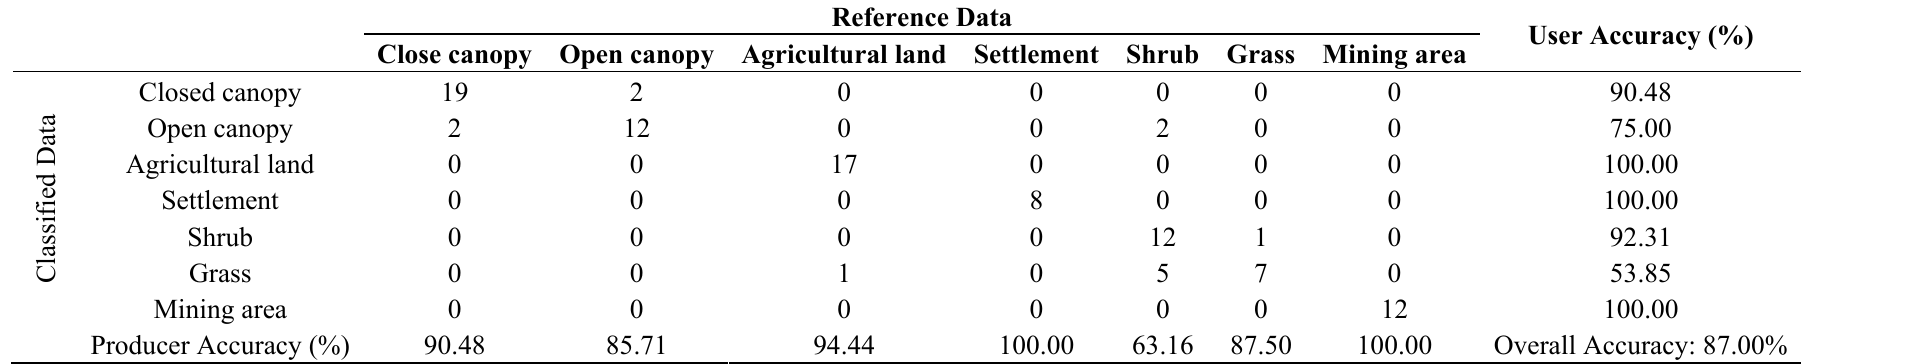
Table S1. Confusion matrix of land use map of Xinqin village, 2010.